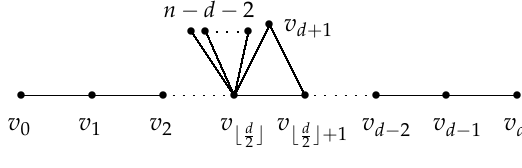
Figure 3. Graph ∆ d n